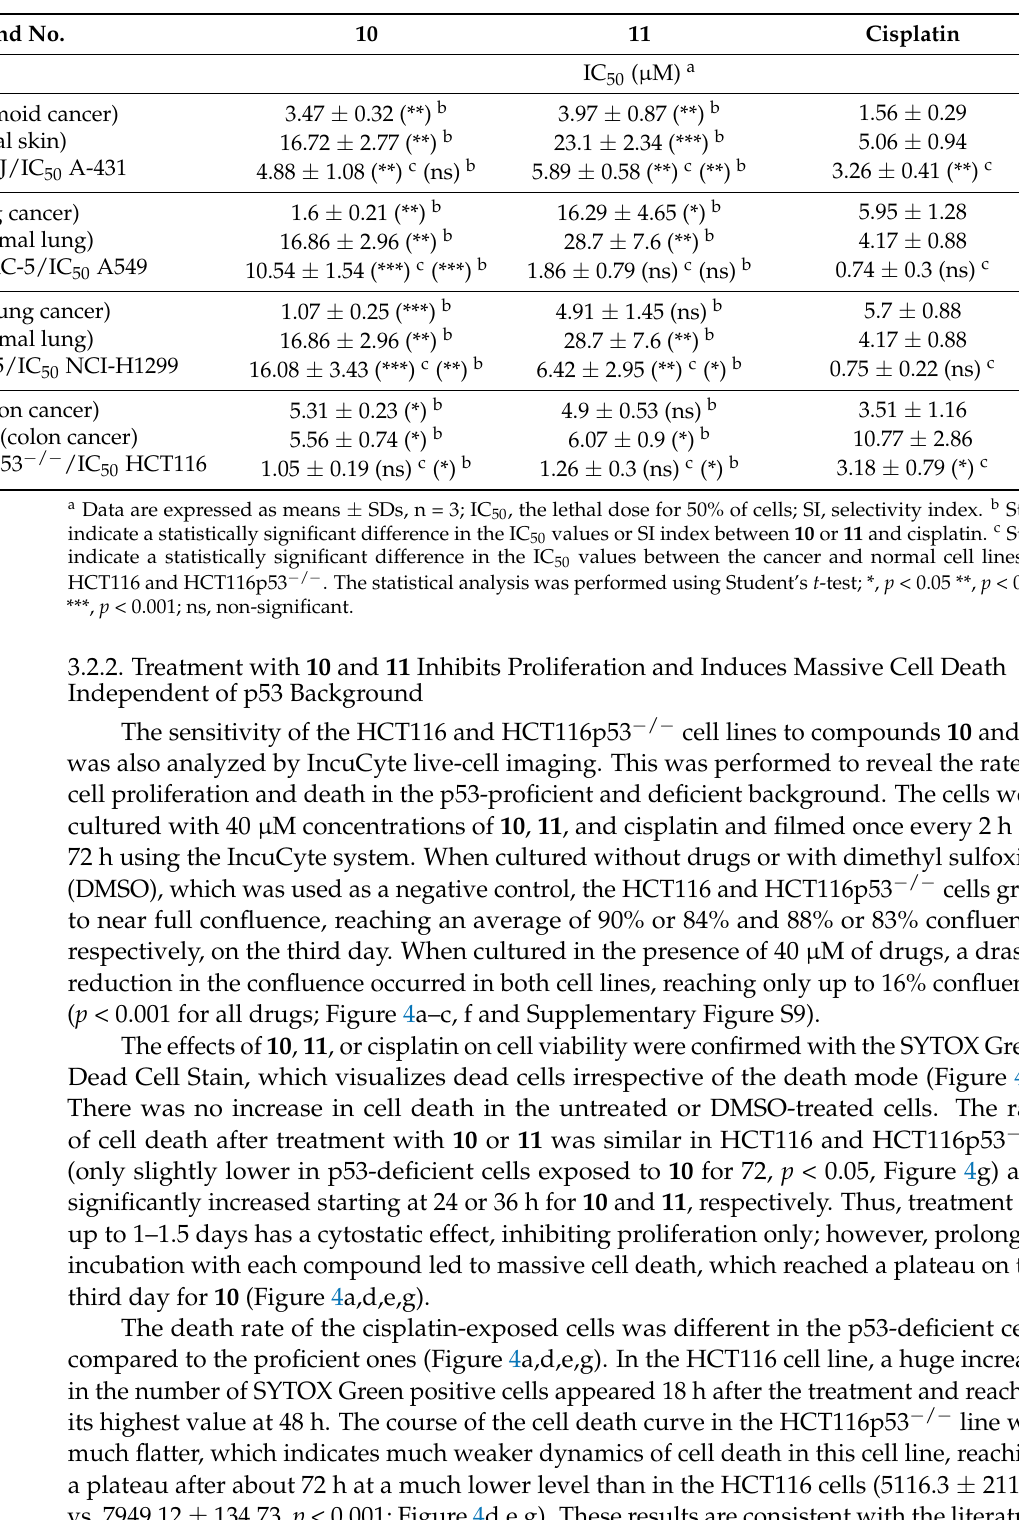
Table 1. Calculated IC 50 values of compounds 10 , 11 , and cisplatin on selected human cell lines in